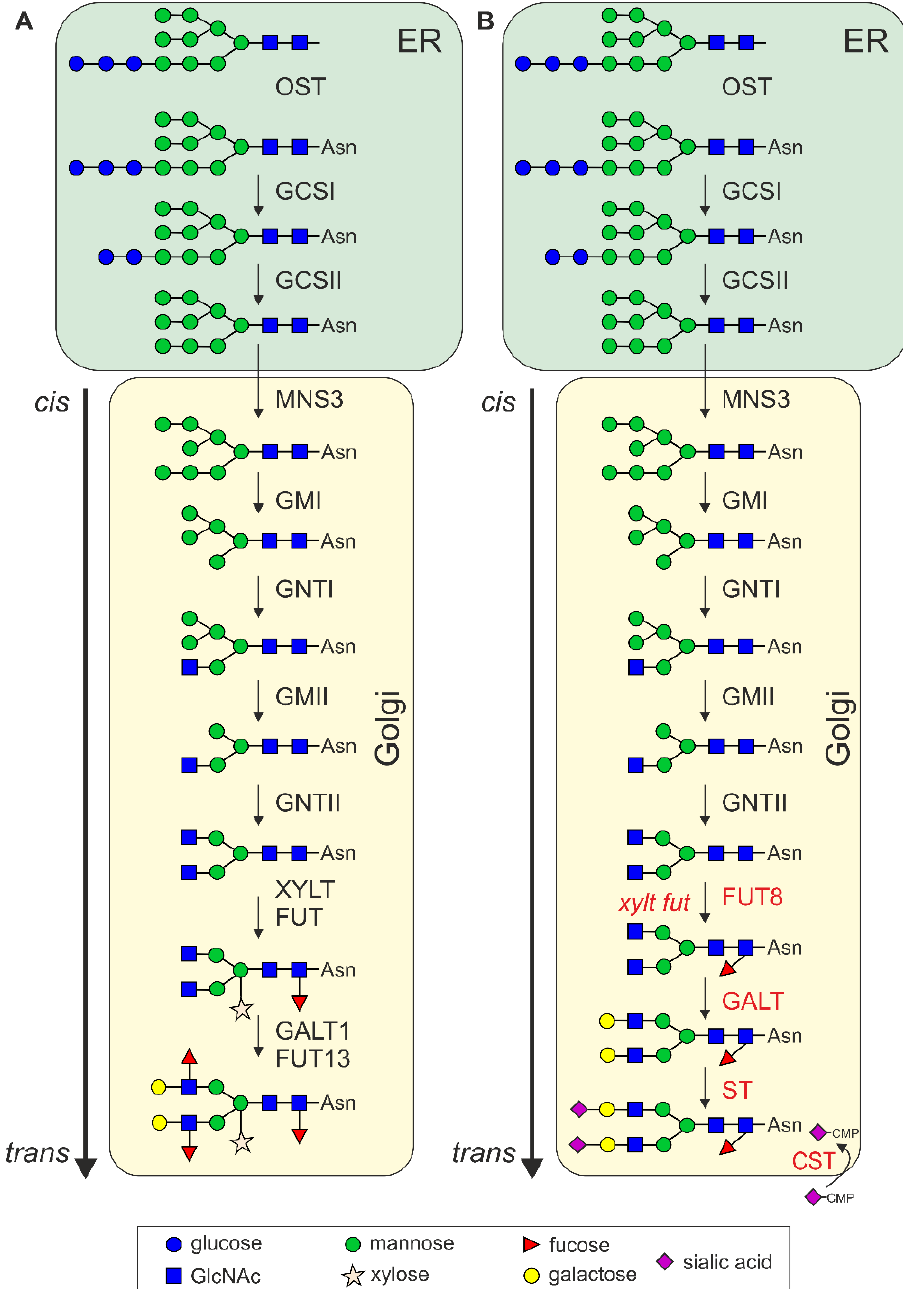
Figure 2. Schematic overview of natural and engineered N -glycan processing pathways. ( A ) N -glycan processing steps in the endoplasmic reticulum (ER) and Golgi apparatus of plants. OST, oligosaccharyltransferase complex; GCSI, α -glucosidases I (GCSI); GCSII, α -glucosidases II; MNS3, ER α -mannosidase; GMI, Golgi α -mannosidase I; GNTI, β 1,2- N -acetylglucosaminyltransferase I; GMII, Golgi α -mannosidase II; GNTII, β 1,2- N -acetylglucosaminyltransferase II; XYLT, β 1,2-xylosyltransferase; FUT, core α 1,3-fucosyltransferases; GALT1, Lewis type β 1,3-galactosyltransferase; FUT13, α 1,4-fucosyltransferase. ( B ) Engineered N -glycan processing pathway in plants. The knockout of XYLT and FUT ( xylt fut ) results in the formation of the GlcNAc 2 Man 3 GlcNAc 2 (GnGn) structure, which serves as the acceptor substrate for β 1,4-galactosyltransferase (GALT, β 1,4-galactosylation) and core α 1,6-fucosyltransferase (FUT8, core a1,6-fucosylation). Capping with terminal sialic acid is achieved by expression of α 2,6-sialyltransferase (ST, a2,6-sialylation) together with the Golgi CMP-sialic acid transporter (CST) and proteins for CMP-sialic acid biosynthesis (not shown) [36,60]. In mammalian cells, the innermost GlcNAc residue of complex N -glycans is fre- quently modified by core α 1,6-fucosyltransferase (FUT8) which transfers a fucose in α 1,6- linkake instead of the α 1,3-fucose that is attached by plant FUT. N -Acetylglucosaminyl-